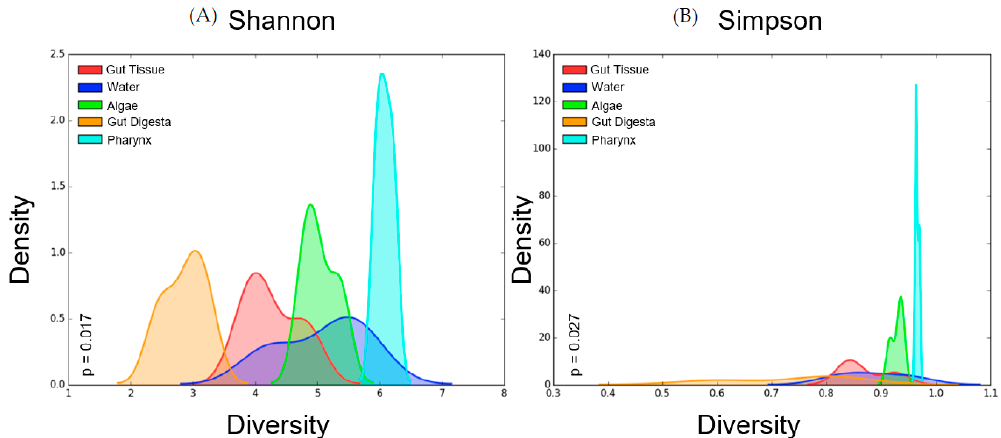
Figure 4. Per-group alpha diversity measurements calculated across all samples in the study. (A) Shannon and (B) Simpson alpha diversity histograms were smoothed by kernel density estimation.